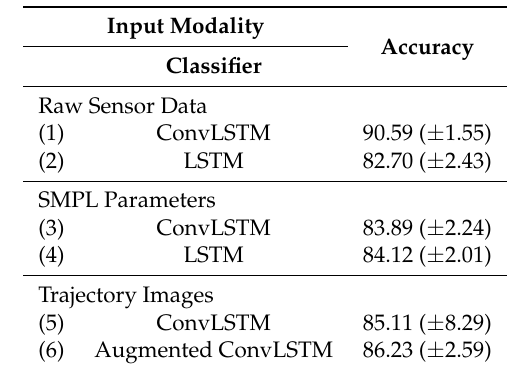
Figure 4. Model performance on DIP-IMU data over varying numbers of subjects on all 6 IMU signal inputs. Table 2. Accuracy comparison of methods on DIP-IMU dataset with all 10